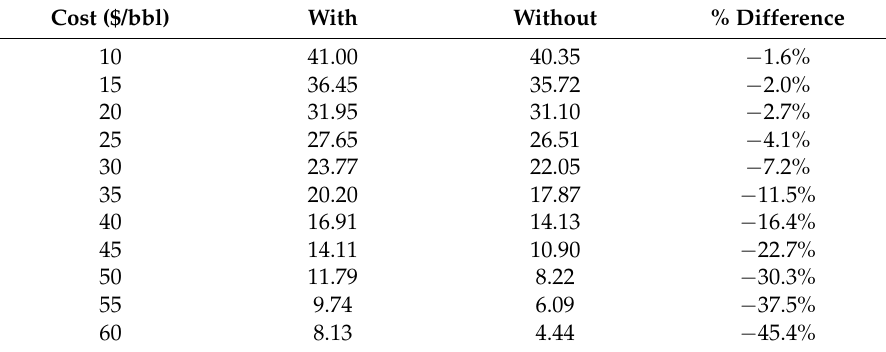
Table 3. Value of the option to defer investment with and without stochastic volatility. Cost ($/bbl)